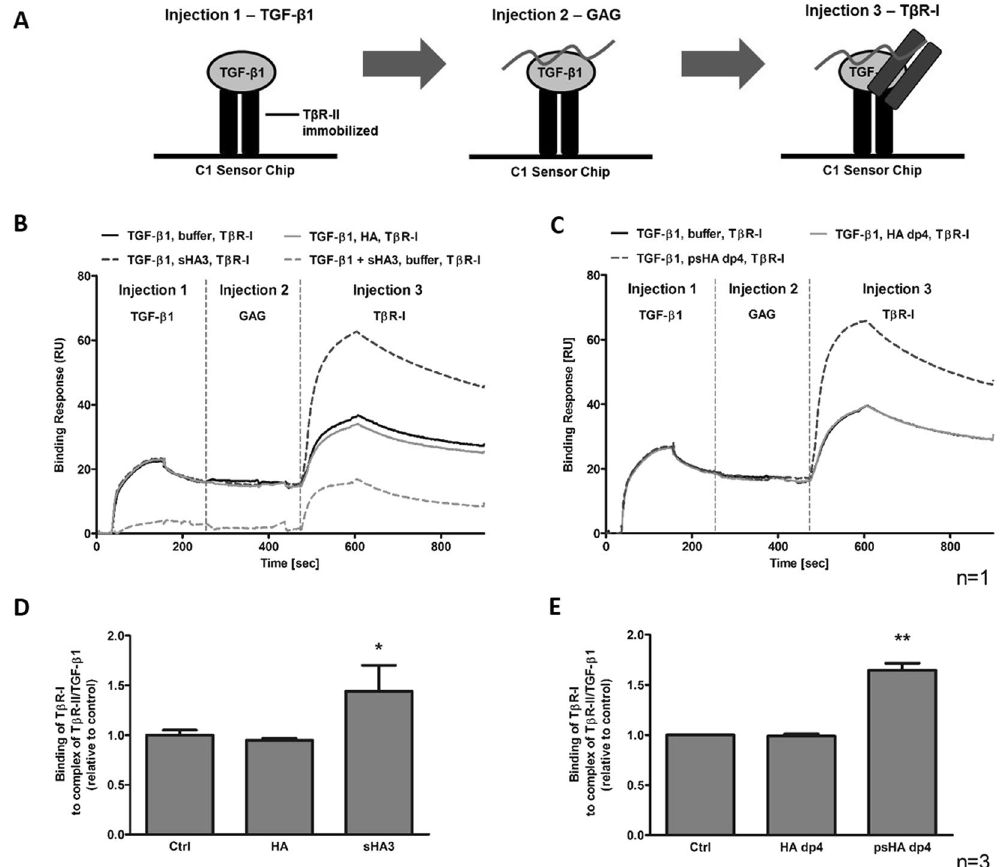
Figure 3. Sequential TGF- β 1:receptor complex formation in the presence of different HA derivatives. ( A ) Schematic drawing of the experimental set-up showing that T β R-II was immobilized on a C1 Sensor Chip and all other components were injected in the order: TGF- β 1, GAG or buffer, T β R-I. Binding of T β R-I to T β R-II/ TGF- β 1 in the presence of ( B ) polymeric HA and sHA3 or ( C ) HA dp4 and psHA dp4. The sensorgrams display one representative experiment out of at least three independent measurements. Binding levels for the association of T β R-I to the complex of T β R-II/TGF- β 1 including the indicated ( D ) polymeric or ( E ) tetrameric GAGs were ranked. Values represent the mean ± SD of n = 3. One-way ANOVA: * p < 0.05; ** p < 0.01 vs. control or